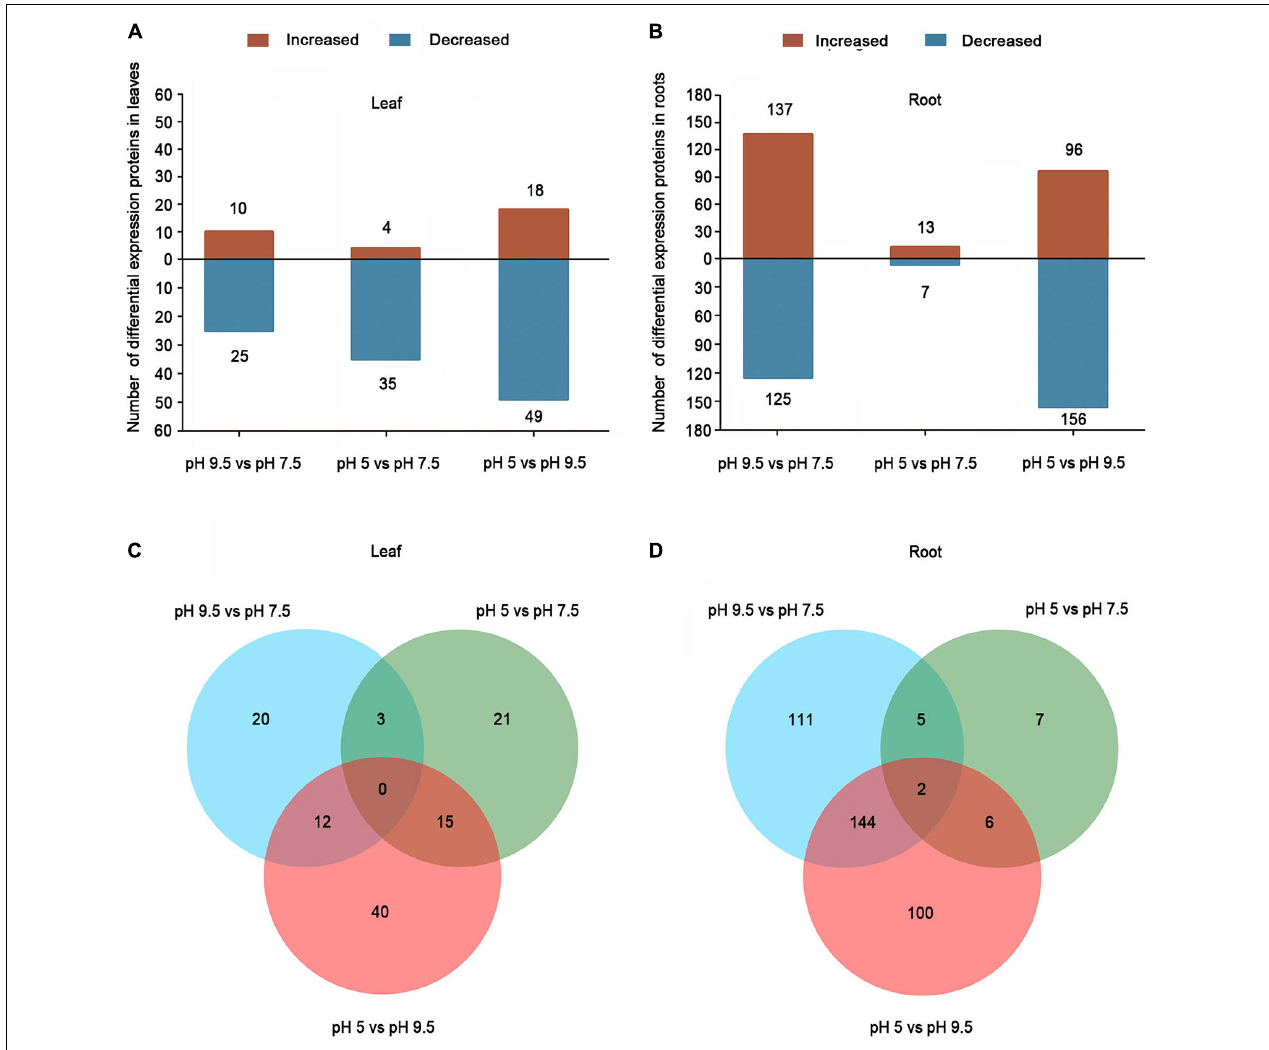
FIGURE 3 | Differentially expressed proteins (DEPs) in the leaves and roots of sugar beet in different pH comparison groups. Numbers of DEPs in leaf (A) and root (B) at different salt treatments. Venn diagrams of DEGs among different pH comparison groups in leaf (C) and root (D)